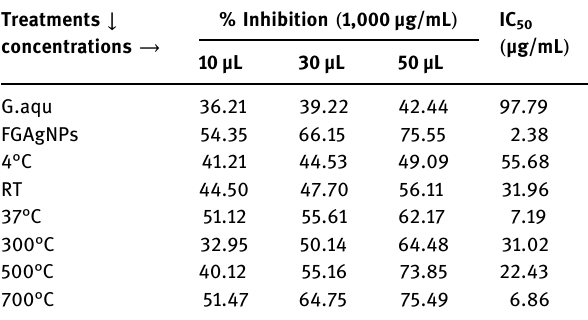
Table 3: Antidiabetic e ff ect of green - synthesized silver nanoparticles ( GAgNPs ) and the extract of Allium sativum ( Gaqu ) Treatments